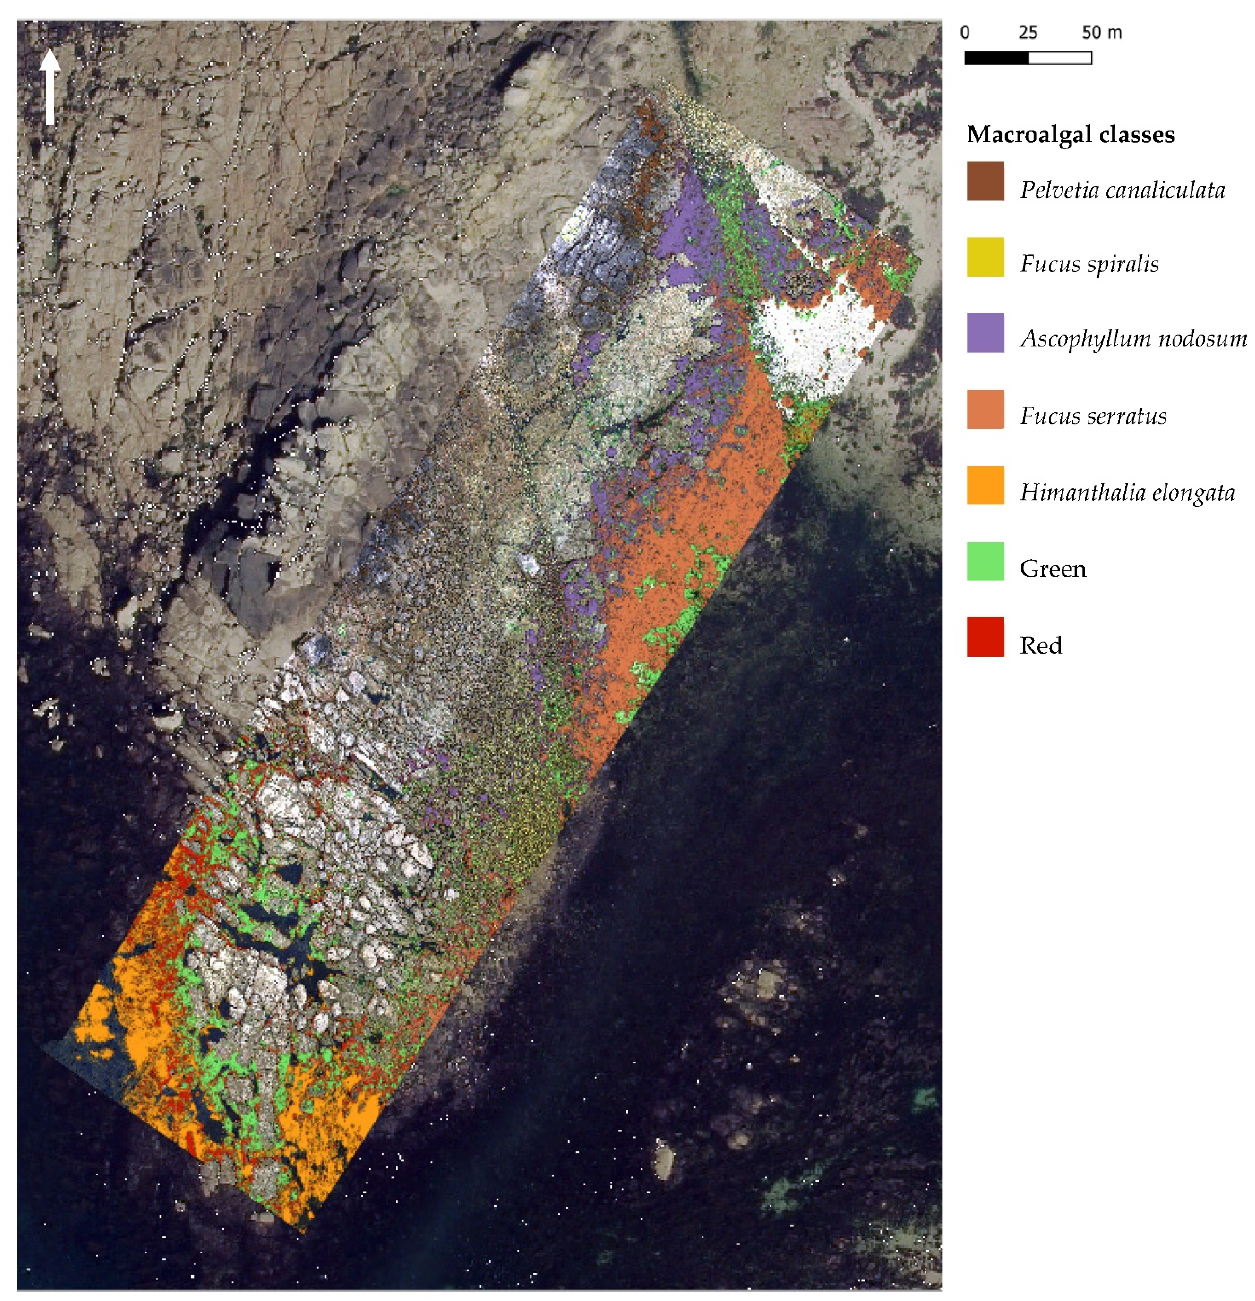
Figure 7. Maximum likelihood classification (MLC), trained using image-derived spectra resulting from the hyperspectral UAV survey at Porspoder. Seven macroalgal cover classes are displayed over the UAV RGB imagery and an orthophotography (Mégalis Bretagne et collectivités territoriales bretonnes—2015), giving an overview of the site. The ‘Substratum’ and ‘Water’ classes are not represented on the map. Class codes ‘Green’ and ‘Red’ represent grouped green and red macroalgal species, respectively. Table 4. Maximum likelihood classification (MLC) confusion matrix, calculated, using ENVI 5.6.1, by comparing pixels of known class locations to those predicted by the classification workflow for each of the nine cover classes. Results are displayed as percentages of pixels assigned, correctly or incorrectly, to each class. User/producer accuracies (User Acc. and Prod. Acc., respectively) are also presented.